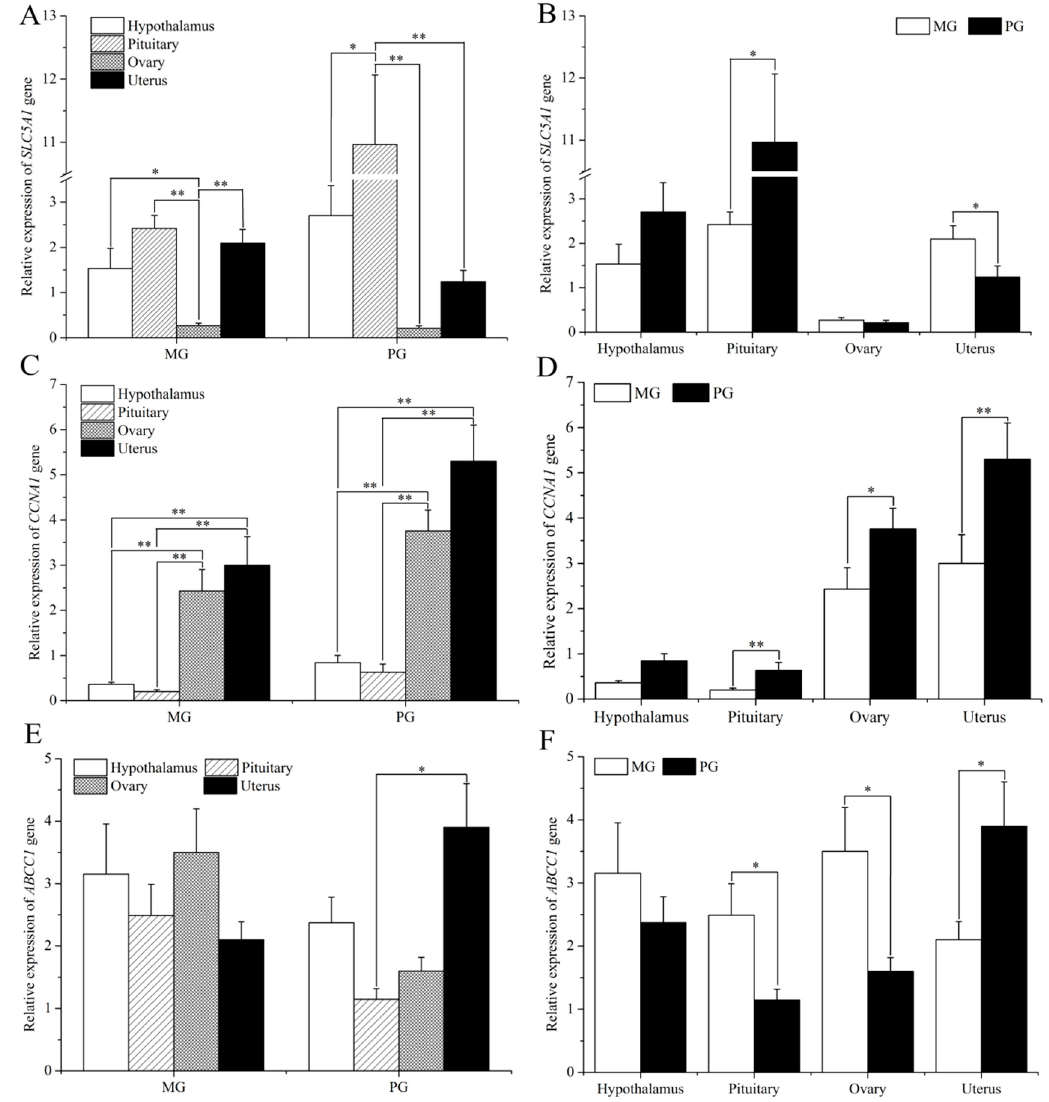
Figure 1. Expression of SLC5A1 , CCNA1 , and ABCC1 in reproductive tissues of Small-Tail Han sheep. ( A ) Expression of SLC5A1 in the hypothalamic–pituitary–gonadal (HPG) axis of Small Tailed Han sheep; ( B ) expression of SLC5A1 in reproductive tissues of polytocous and monotocous Small-Tail Han sheep; ( C ) expression of CNNA1 in the HPG axis of Small-Tail Han sheep; ( D ) expression of CNNA1 in reproductive tissues of polytocous and monotocous Small-Tail Han sheep; ( E ) expression of ABCC1 in the HPG axis of Small-Tail Han sheep; ( F ) expression of ABCC1 in reproductive tissues of polytocous and monotocous Small-Tail Han sheep. Note: *: p < 0.05; **: p < 0.01.